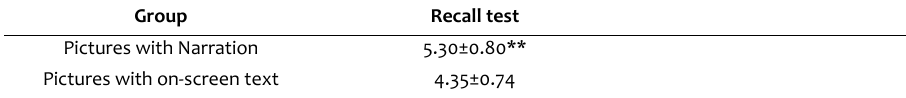
Table 2. Mean scores and standard deviations on recall test for the treatment